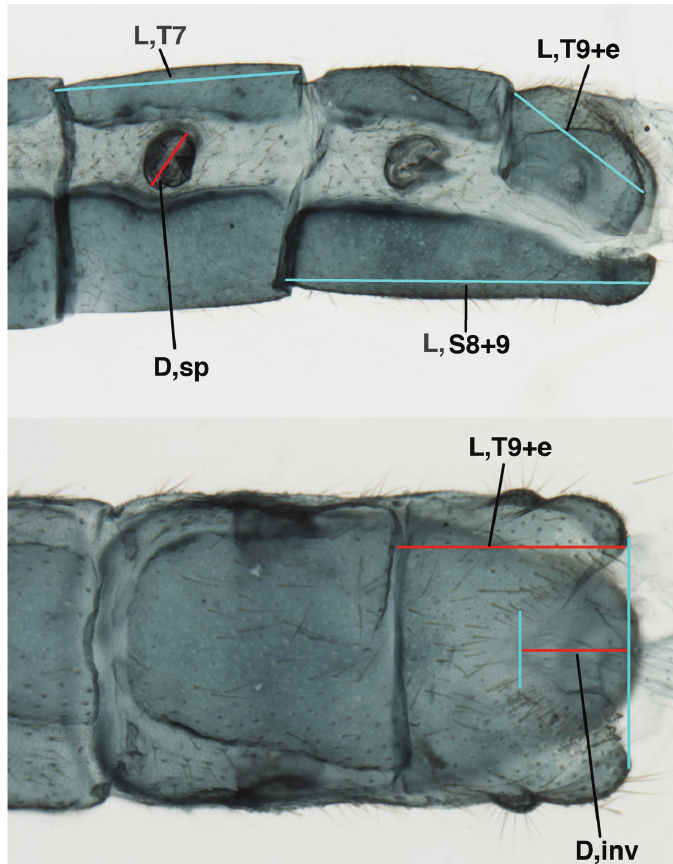
Figure 3. Measurements of male abdomen; upper, lateral; lower, dorsal. D,inv depth of invagination D,sp maximum diameter of spiracular opening L,T7 length of seventh tergite L,T9+e length of ninth tergite plus ectoproct L,S8+9 length of fused eighth and ninth = Pseu domedia, Cu = Cubitus, Psc = Pseudocubitus, x = crossvein [e.g., R-Rsx =